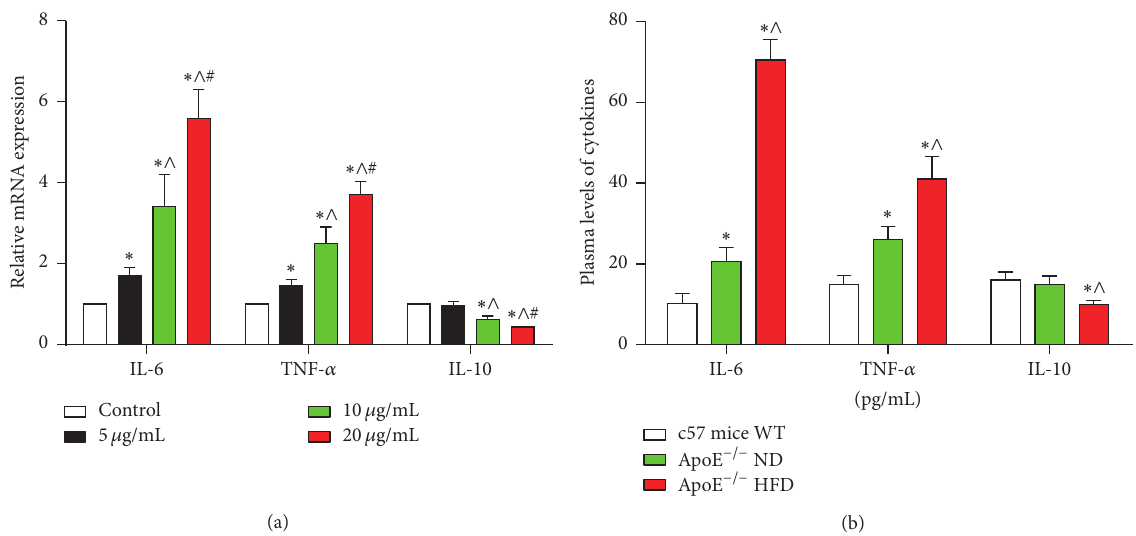
Figure 2: The levels of cytokines IL-6, TNF- 𝛼 , and IL-10 in RAW264.7 cells after ox-LDL treatment and atherosclerotic mice. (a) ox-LDL induced the expression of IL-6, TNF- 𝛼 , and IL-10 for 24 h at indicated dose was determined by qPCR: ∗ 𝑝 < 0.05 , relative to control, ∧ 𝑝 < 0.05 , relative to 5 𝜇 g/mL ox-LDL group; # 𝑝 < 0.05 , relative to 10 𝜇 g/mL ox-LDL group. (b) The plasma levels of IL-6, TNF- 𝛼 , and IL-10 of c57 mice WT, ApoE −/− ND, and ApoE −/− HFD were detected by the ELISA kit ( 𝑛 = 6 ): ∗ 𝑝 < 0.05 , relative to c57 mice WT; ∧ 𝑝 < 0.05 , relative to ApoE −/−